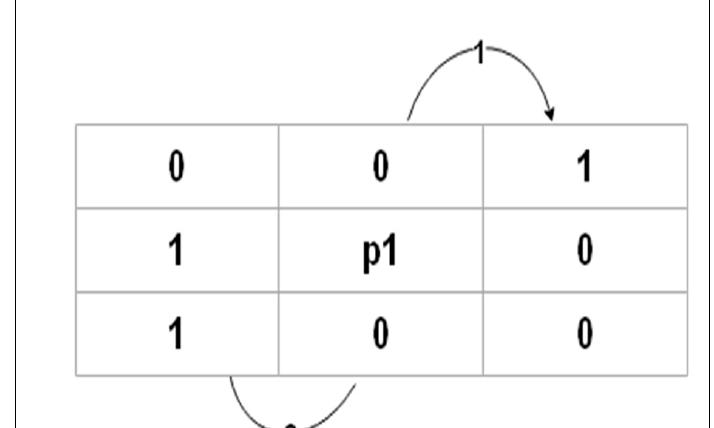
Figure 3. Designations of the pixels in a 3 × 3 window. Each iteration is separated into two subiterations to preserve the structure of the skeleton. See Algorithm 1 and Figure 4.